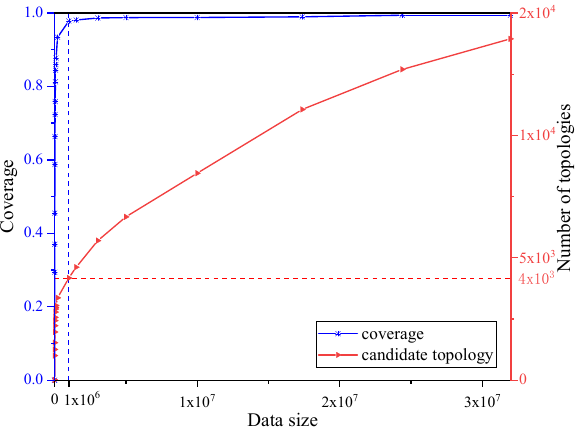
Figure 6. The relationship between data size and topology coverage.